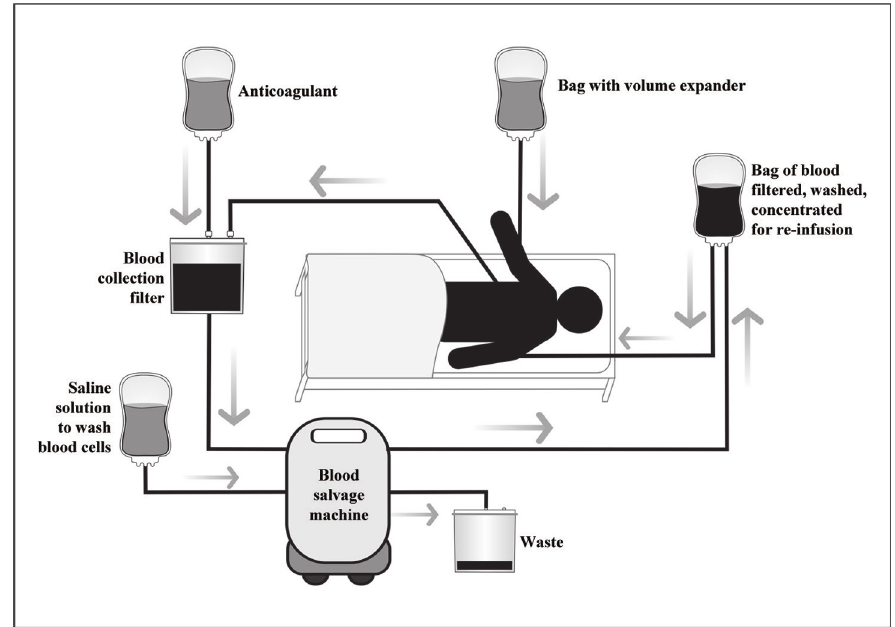
Fig. 4 - Schematic representation of intraoperative blood recovery. The collected blood is mixed with anticoagulant, filtered, washed, concentrated and returned to the